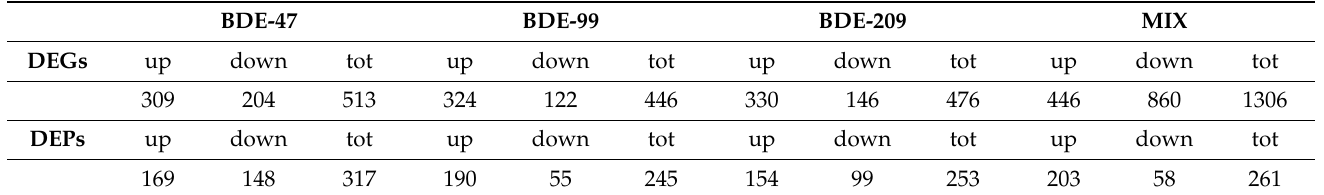
Table 1. Number of differentially expressed genes (DEGs) and proteins (DEPs) identified in HepG2 cells following treatment for 72 h with BDE-47, -99, -209 and their ternary mixture (MIX) at 1